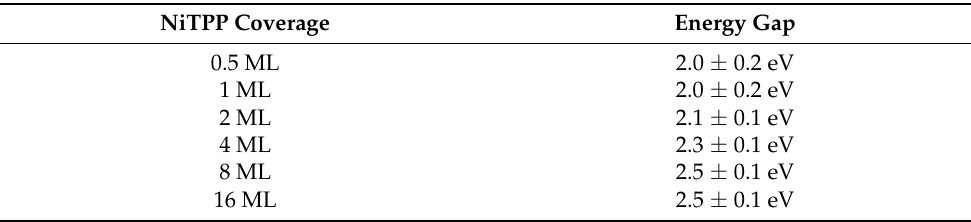
Table 1. HOMO-LUMO calculated for the system NiTPP/Fe– p (1 × 1)O as a function of the thickness of the deposited molecular